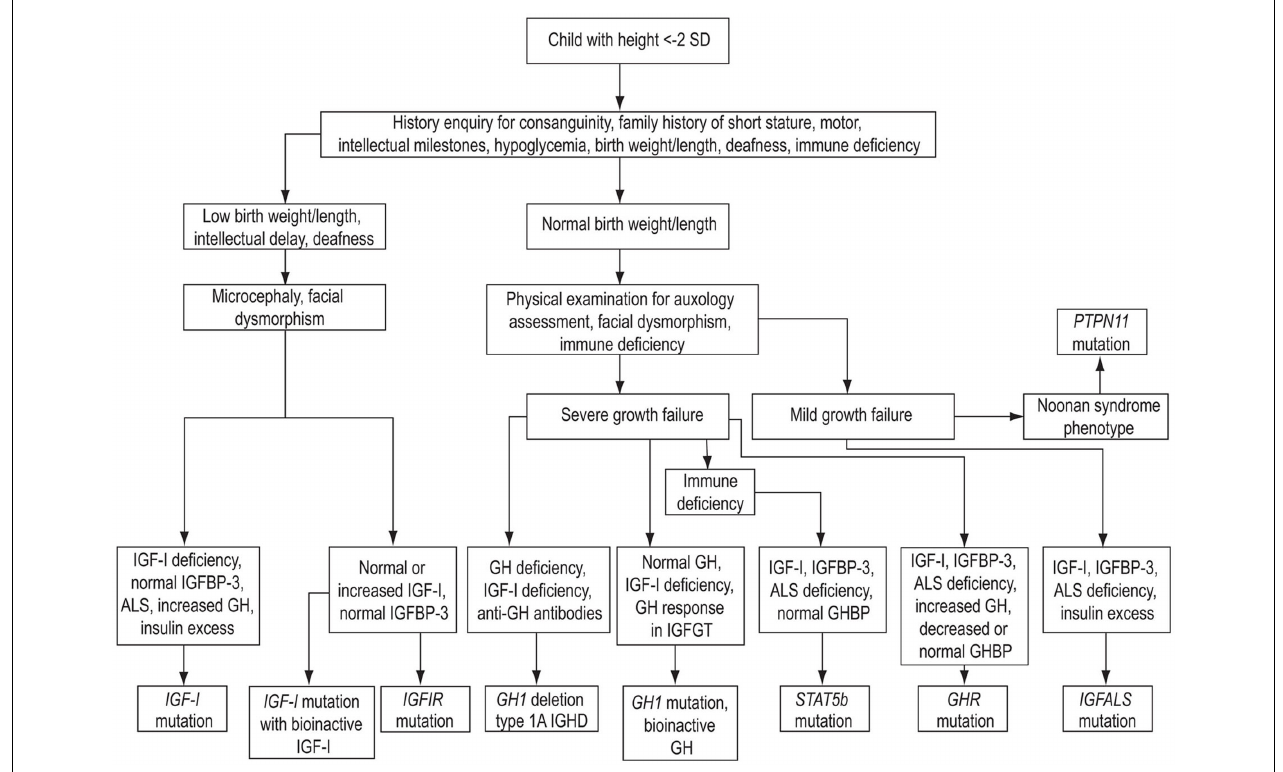
FIGURE 4 |Algorithm showing key steps in the investigation of genetic GH–IGF-I axis defects. SD, standard deviation; IGHD, isolated growth hormone deficiency; ALS, acid-labile subunit; IGFBP-3, IGF-binding